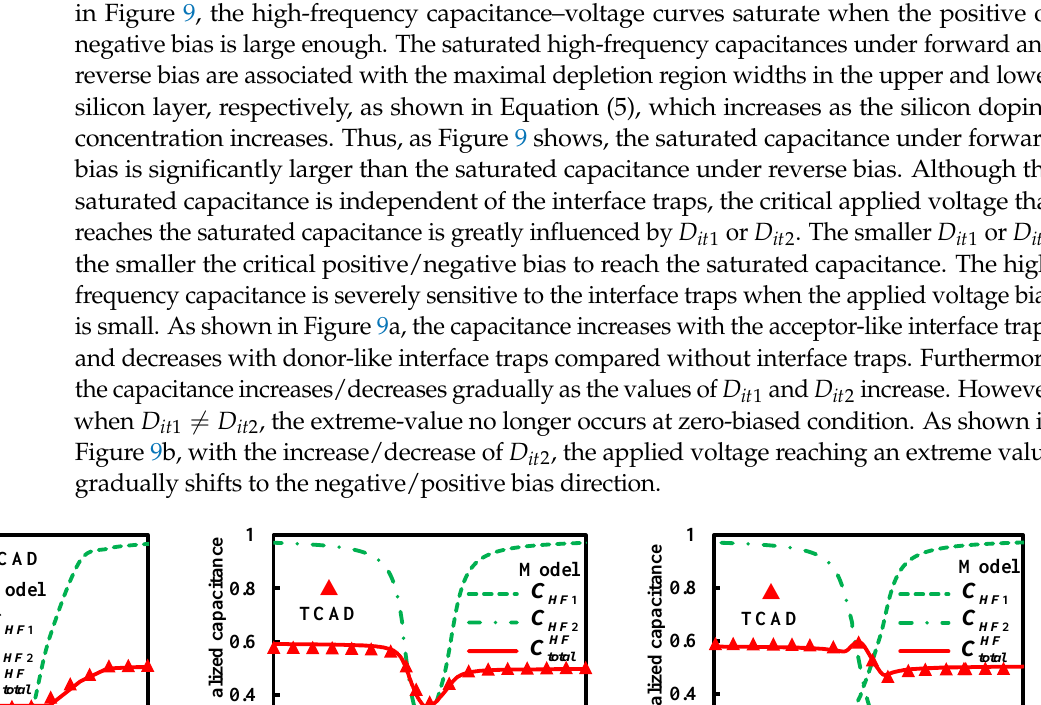
Figure 7. Different high-frequency capacitance – voltage curves of the staked bonding structure. ( a ) V FB = -2.5 V, ( b ) V FB = -0.5 V, ( c ) V FB = 0 V, ( d ) V FB = 0.5 V and ( e ) V FB = 2.5 V.